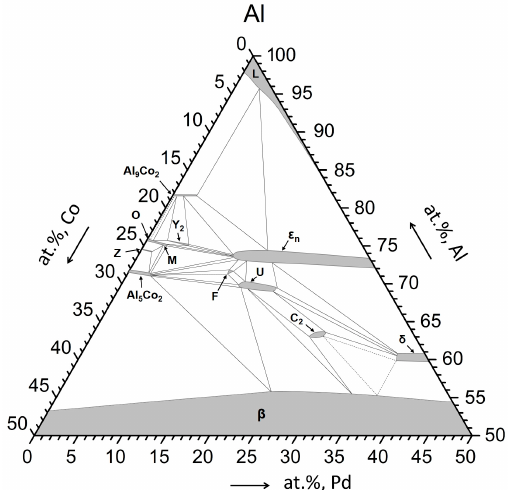
◦ C, redrawn from Reference